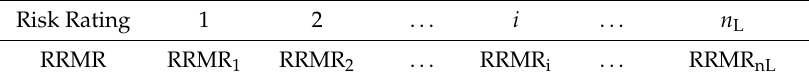
Table 1. The reserved risk maintenance resources